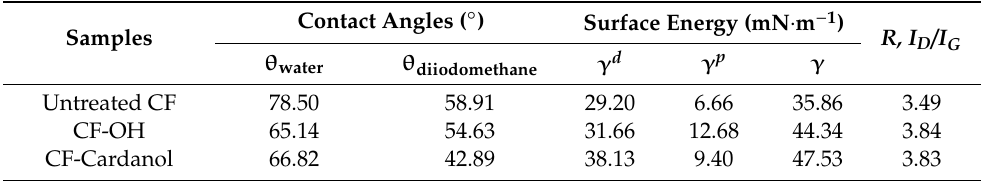
Table 2. Contact angles, surface energy, and the integral area ratio of D to G of di ff erent CFs.